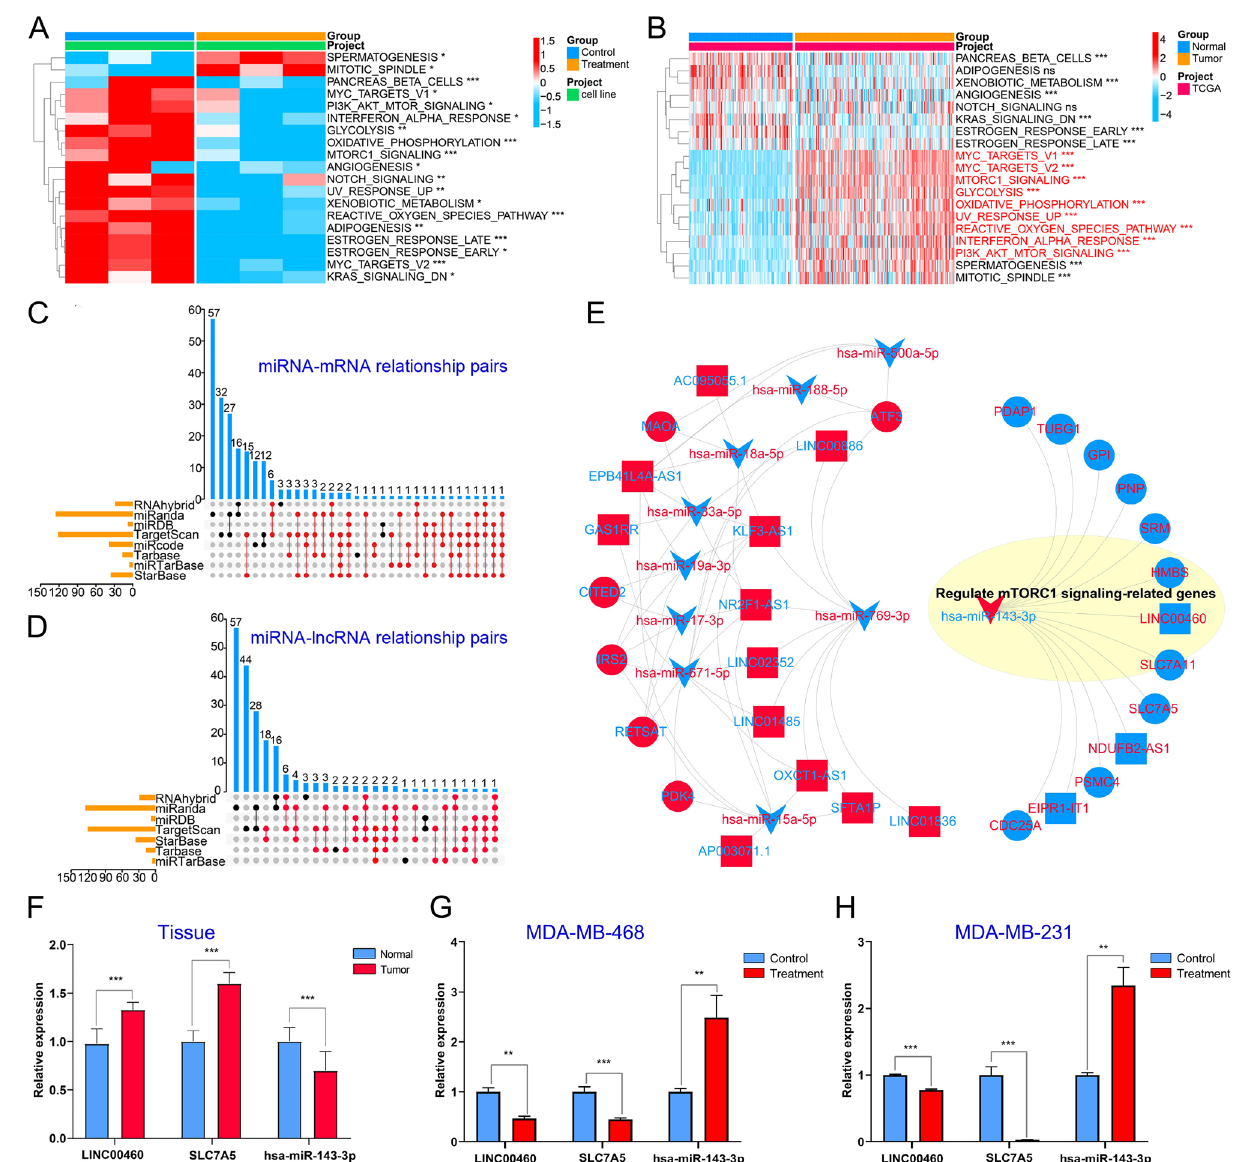
Figure 3. Construction of BEZ235-related ceRNA network. ( A , B ) GSVA analysis screened for differential Hallmark pathways between tumor and normal, and between BEZ235-treated and control group, respectively. The upset diagrams were used to screen the intersection miRNA-mRNA pairs ( C ) and miRNA-lncRNA pairs ( D ), and the dot-lines in red represented the selected relationship pairs. ( E ) BEZ235-related ceRNA network was built by Cytoscape. The red shape/font represents the genes upregulated in BEZ235-treated cell lines/TNBC tissue, and the blue shape is the opposite. ( F – H ) The RT-qPCR analysis was used to verify the expression levels of 3 genes, including LINC00460, SLC7A5and hsa-miR-143-3p. “***” P < 0.001, “**” P < 0.01, “*” P <